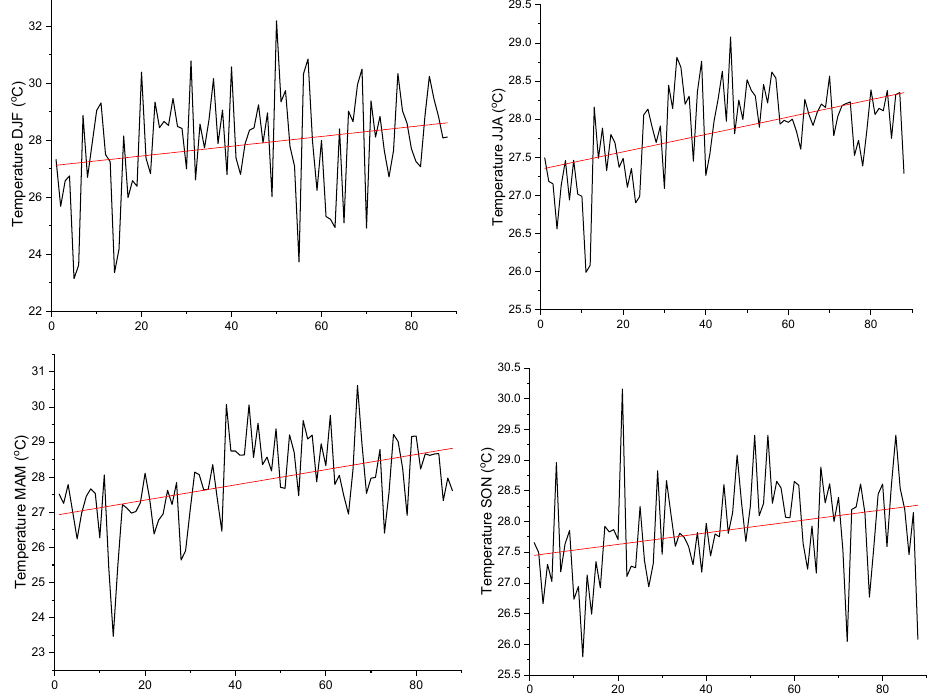
Mean temperature and total monthly rainfall data from six weather stations were divided into seasonal subsets; for example, winter (December, January, February = DJF), summer (June, July, August = JJA), spring (March, April, May = MAM) and autumn (Sep- tember, October, November = SON) seasons. Seasonal data analysis demonstrated that mean monthly temperature during DJF ( τ = 0.173, S = 0.016, p < 0.01), MAM ( τ = 0.358, S = 0.02 (Sen’s slope), p < 0.0001), JJA ( τ = 0.362, S = 0.011, p < 0.0001), and SON ( τ = 0.335, S = 0.014, p < 0.0001), has increased significantly ( p < 0.05) over the 30 year period of observa- tion. As indicated by the Mann Kendall tau value, increasing trends are comparatively prominent during summer, spring and autumn (Figure 4). Figure 3. State-wide total annual average rainfall in the state of Qatar from 1987–2016. Data source QMD.